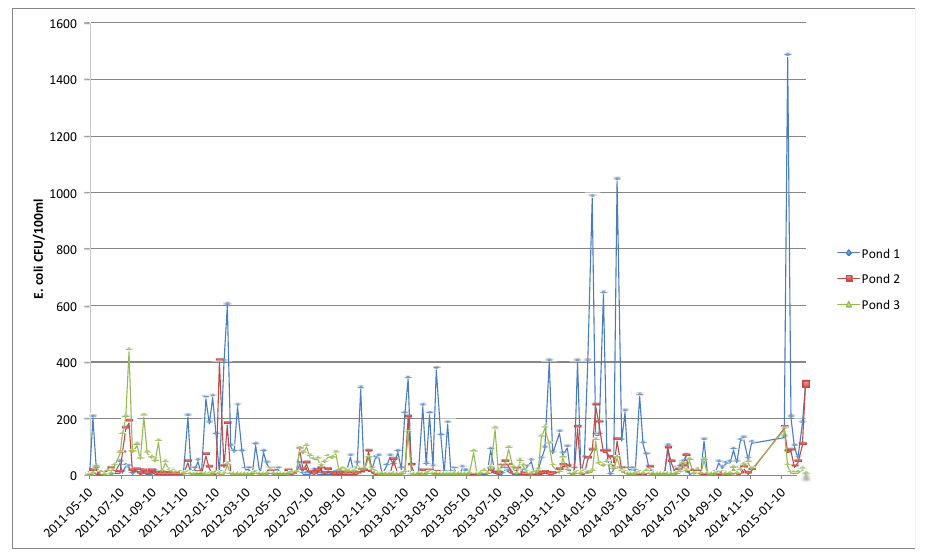
Figure 2. E. coli concentrations in the effluents of Pond 1, Pond 2 and Pond 3 of the Amherstview WPCP.